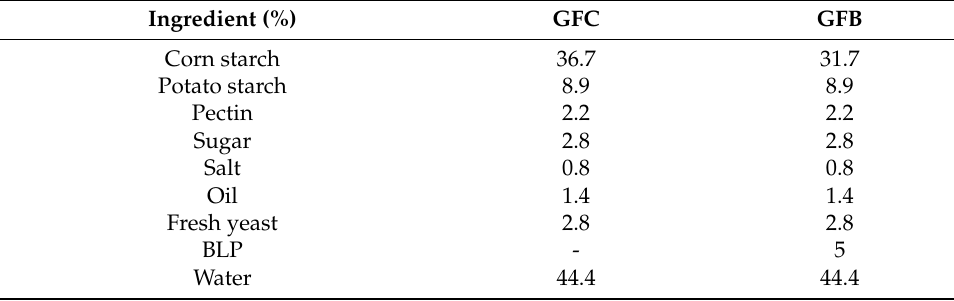
Table 1. Composition of experimental gluten-free